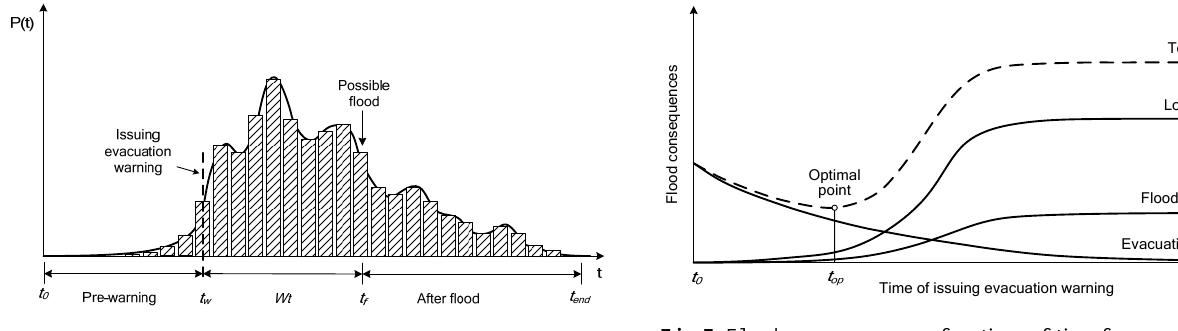
Fig. 6. Probability of dam-break flood as a discrete stochastic process of time.